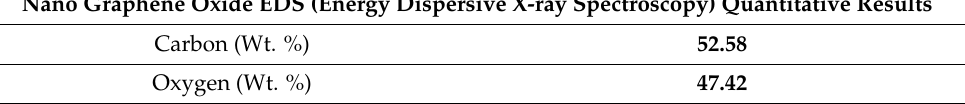
Nano Graphene Oxide EDS (Energy Dispersive X-ray Spectroscopy) Quantitative Results Carbon (Wt. %)